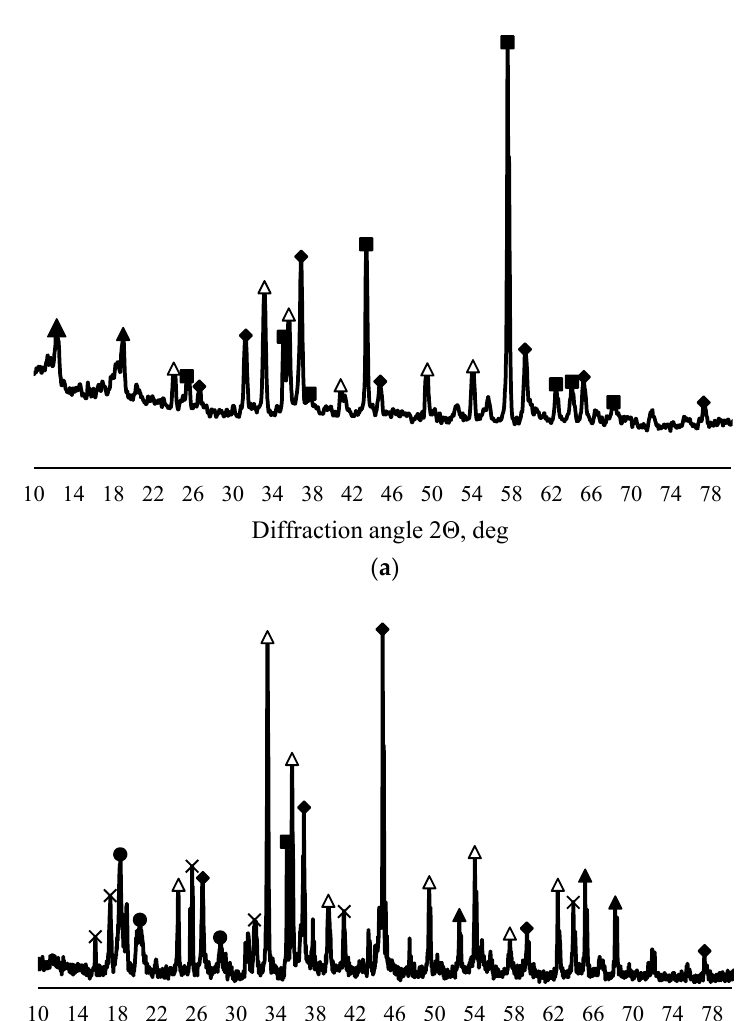
Figure 17. X-ray di ff raction pa tt ern of HACkf concretes in the initial state ( a ) and after irradiation Figure 17. X-ray diffraction pattern of HACkf concretes in the initial state ( a ) and after irradiation ( b ): Δ = Fe 2 O 3 (PDF card 000-33-0664); ■ = Al 2 O 3 (PDF card 000-42-1468); ♦ = MgAl 2 O 4 (PDF card 000- ( b ): ∆ = Fe 2 O 3 (PDF card 000-33-0664); (cid:4) = Al 2 O 3 (PDF card 000-42-1468); (cid:7) = MgAl 2 O 4 (PDF card 21-1152); ▲ = CaAl 2 O 4 10H 2 O (PDF card 000-11-0204); ● = Al(OH) 3 (PDF card 000-12-0460); x = 000-21-1152); (cid:78) = CaAl 2 O 4 10H 2 O (PDF card 000-11-0204); • = Al(OH) 3 (PDF card 000-12-0460); Ca 3 Al 2 (OH) 12 katoite (PDF card 000-24-0217). Ж = Ca 3 Al 2 (OH) 12 katoite (PDF card